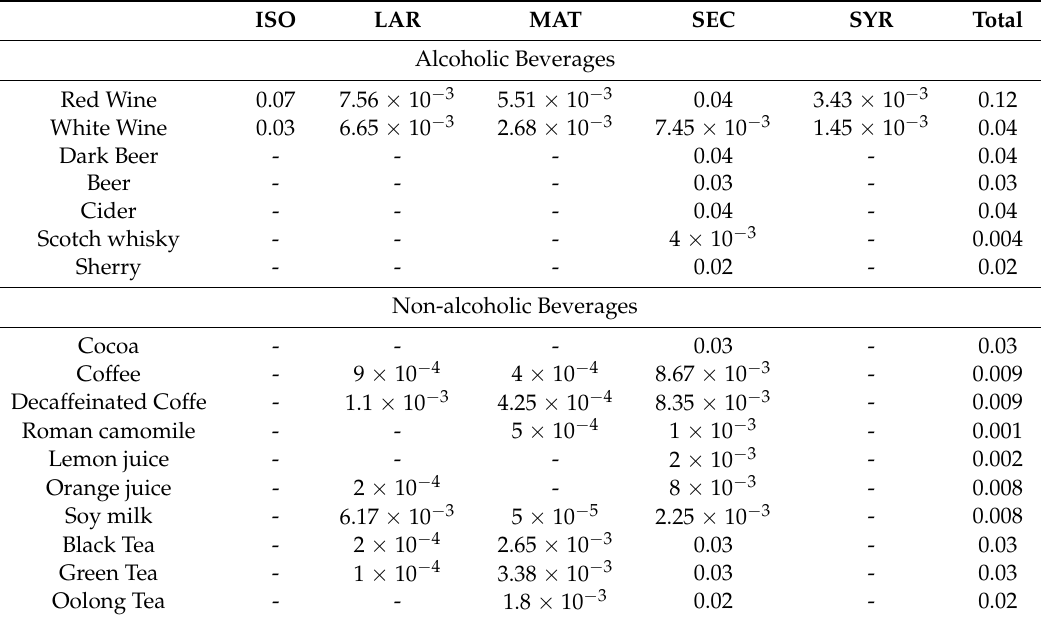
Table 7. Lignan content of beverages (mg/100g drink and mg/100 mL wine) [18].